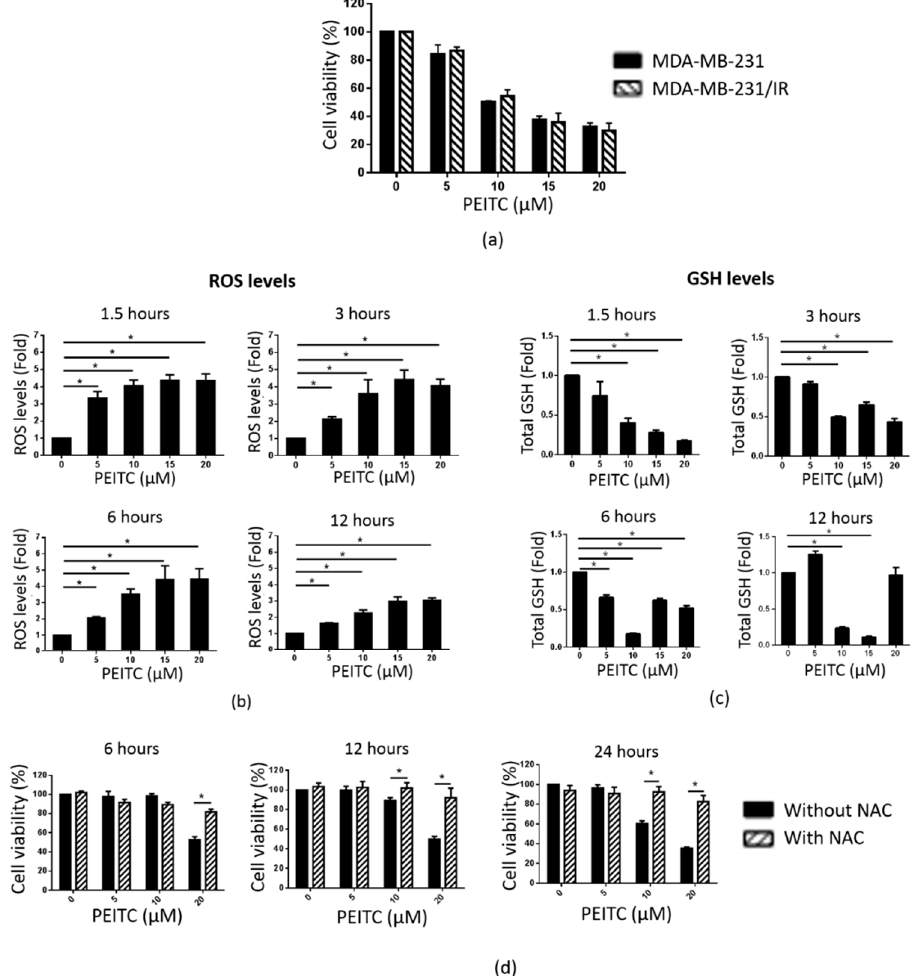
Figure 5. PEITC reduces cell viability in MDA-MB-231/IR cells by increasing ROS levels. ( a )